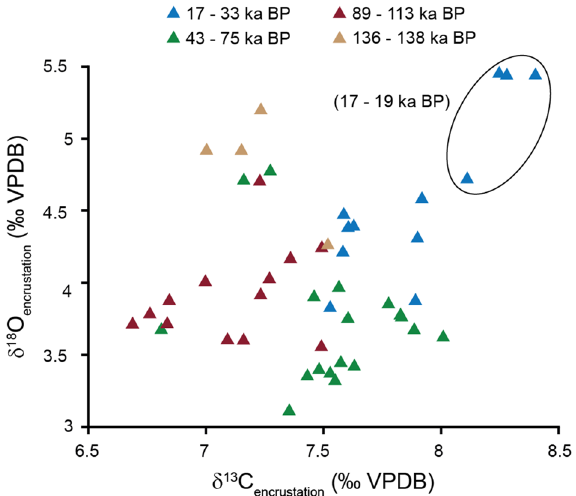
Figure 5. Isotopic variability within aragonite encrustations. Encircled samples are from the late Last Glacial Period (17 to 19 ka BP) exhibiting the highest δ 18 O encrustation and δ 13 C encrustation values. Minor differences can be observed in the oxygen and carbon isotopy of encrustations for different periods (different colouring), suggesting at least a partial environmental control on their isotopic